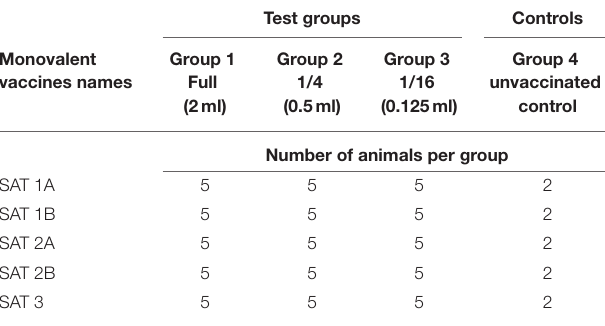
TABLE 1 | Cattle grouping and administration of monovalent vaccines for PD50 (potency)